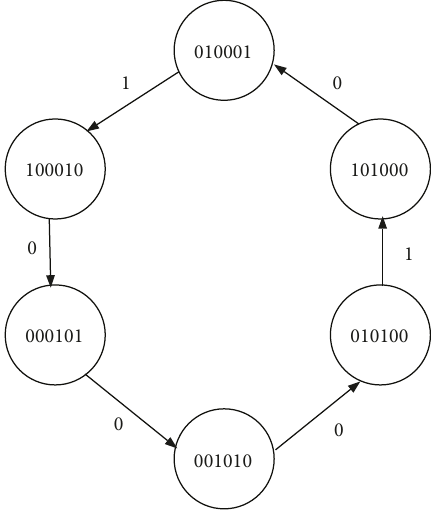
Figure 9: Path forming a cycle in the De Bruijn diagram starting and ending at node 010001 . The result of the evolution is indicated by a number (0 or 1) next to the arrows.